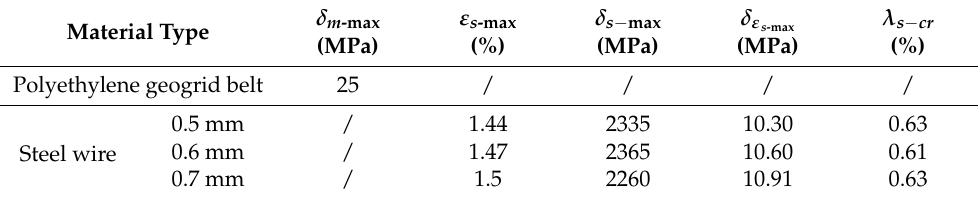
Table 6. Minimum reinforcement ratio when steel wire plays a leading role.